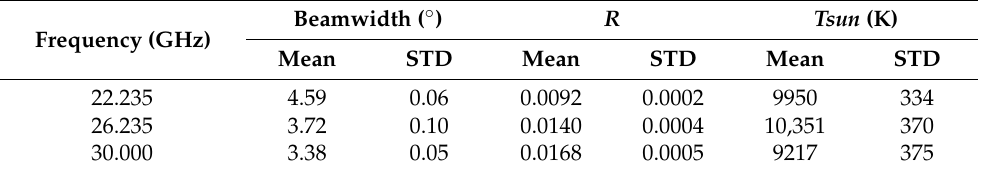
Table 4. The statistical results of the beamwidth, the ratio of the solar solid angle to the antenna solid angle ( R ), and the solar TB (Tsun) from December 2019 to February 2021 at the three frequencies. Beamwidth ( ◦ ) R Tsun Frequency (GHz)